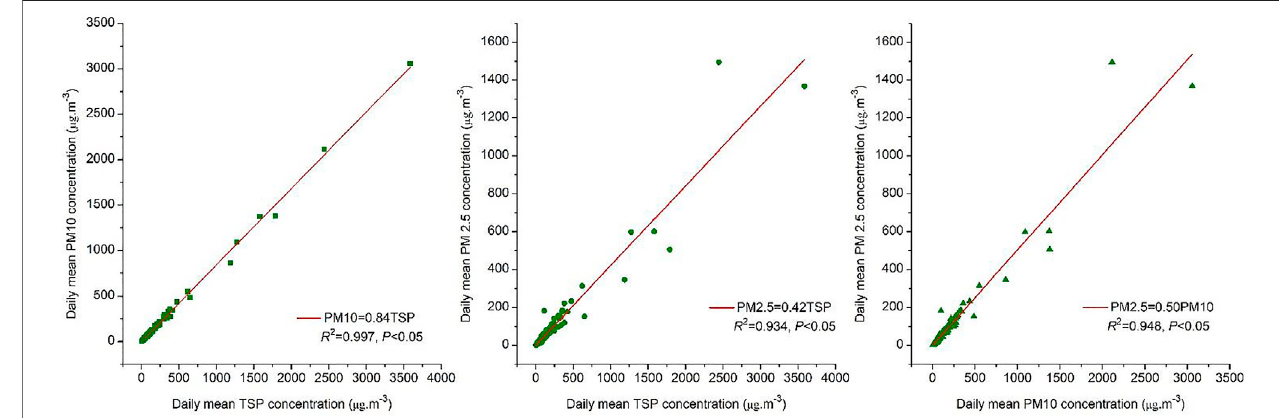
FIGURE 5 | Correlation among the mean concentrations of TSP, PM10, and PM2.5.